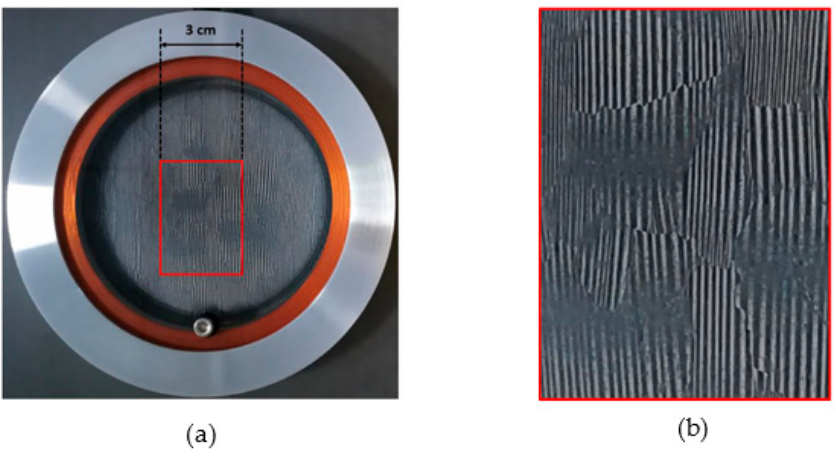
Figure 6. GOES domain pattern detection by means of MBPT. ( a ) Commercial domain viewer Brockhaus DV 90©, ( b ) zoomed view of the domain pattern image, [54] (p. 137).